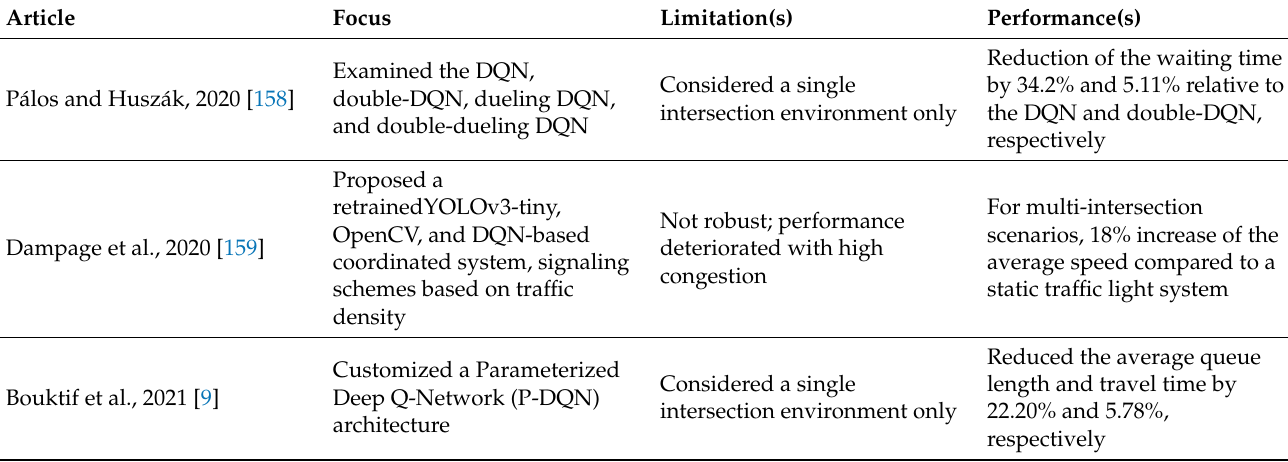
Table 27. Summary of the works found using hybrid